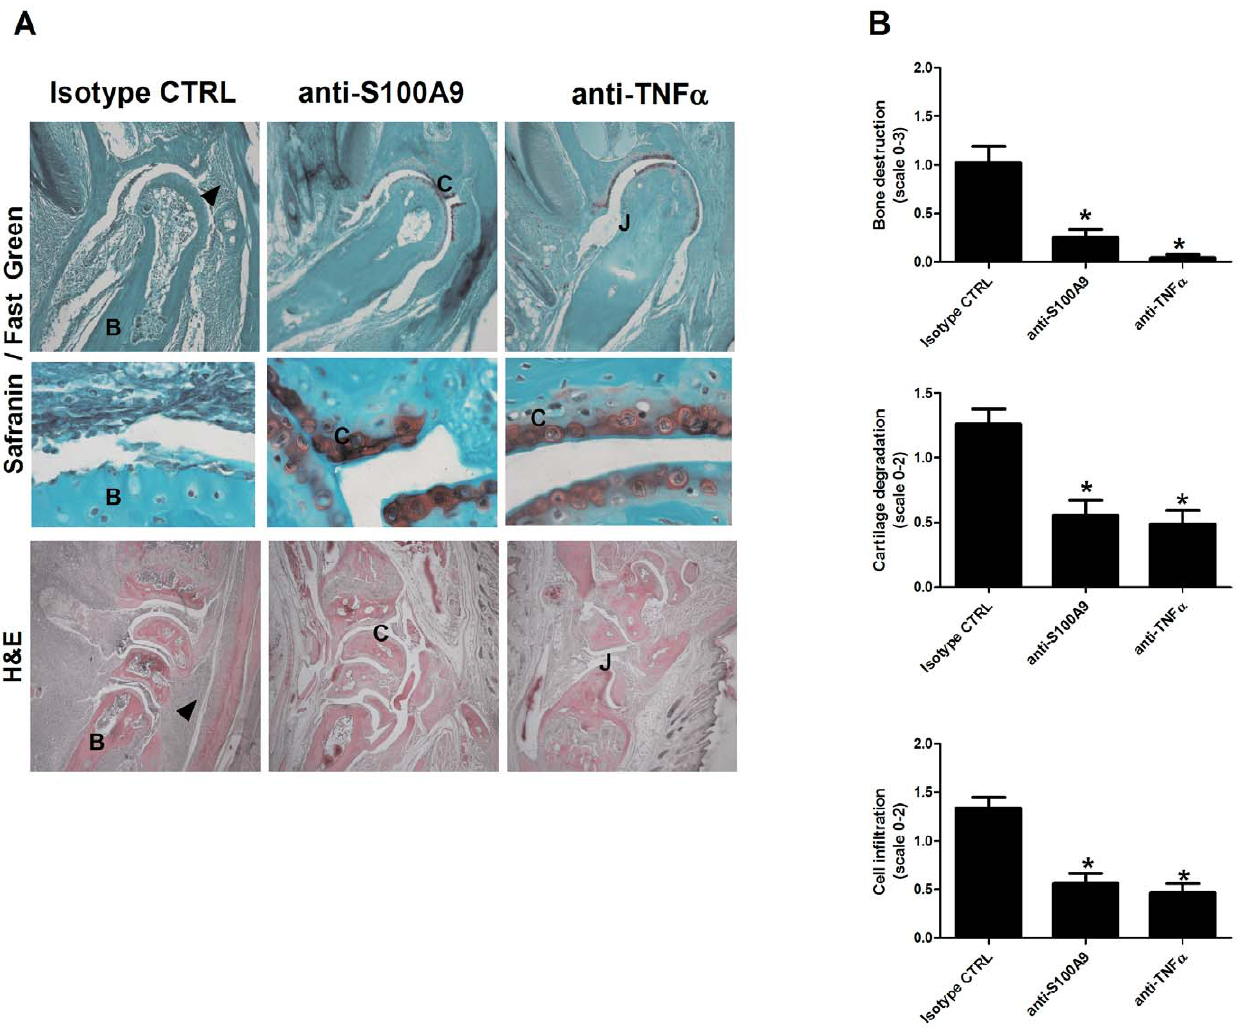
Figure 3. Histological assessment of joint infiltration and destruction in anti-S100A9-, anti-TNF a -, and isotype control-treated animals. (A) H&E-stained sections of wrist at 40 6 magnification and safranin/fast green-stained sections of the distal phalange joints at 100 6 magnification. The enlargement was taken at 1000 6 magnification. B: bone, C: cartilage, J: joint. (B) Bone destruction, collagen degradation, and cell infiltration as assessed by two blinded observers (on a scale of 0–3, 0–2, 0–2, respectively). *p , 0.05, one-way ANOVA test (n =10 paws/group, 5 forepaws and 5 hind paws), Tukey’s multiple comparison test.